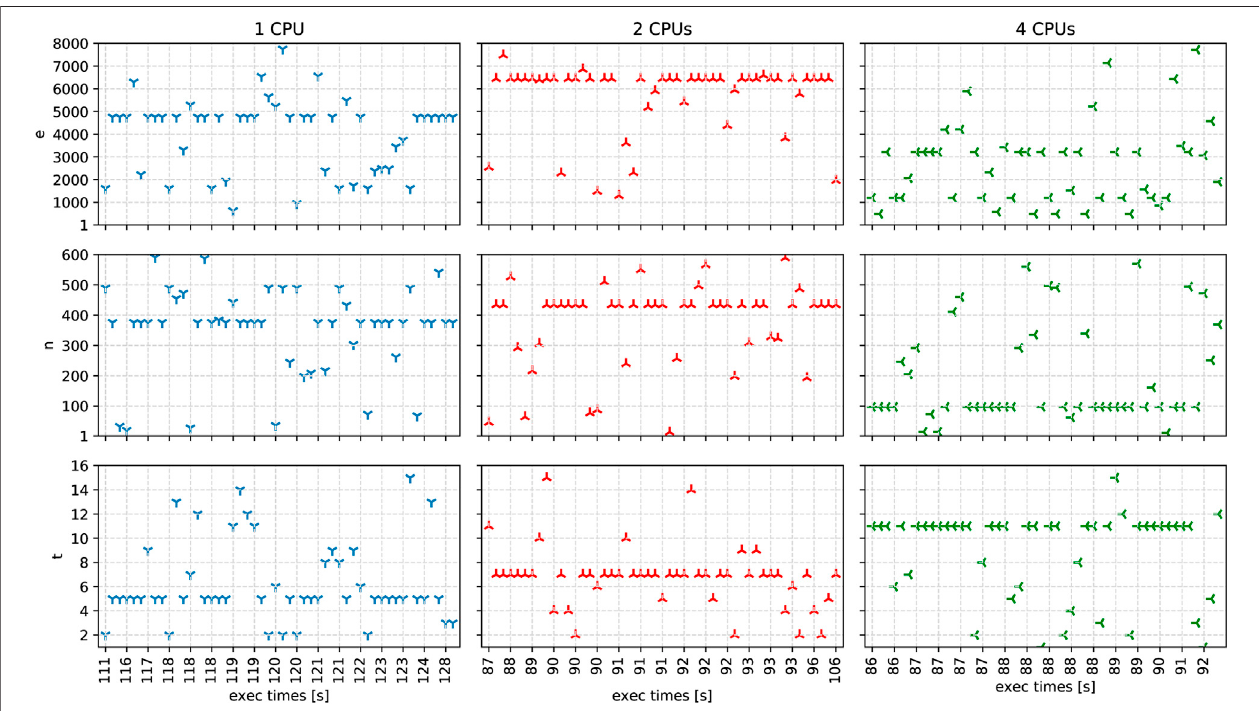
FIGURE 6 | The solutions and their execution times in seconds, generated by the autotuner for one, two, and four CPUs after 50 iterations.